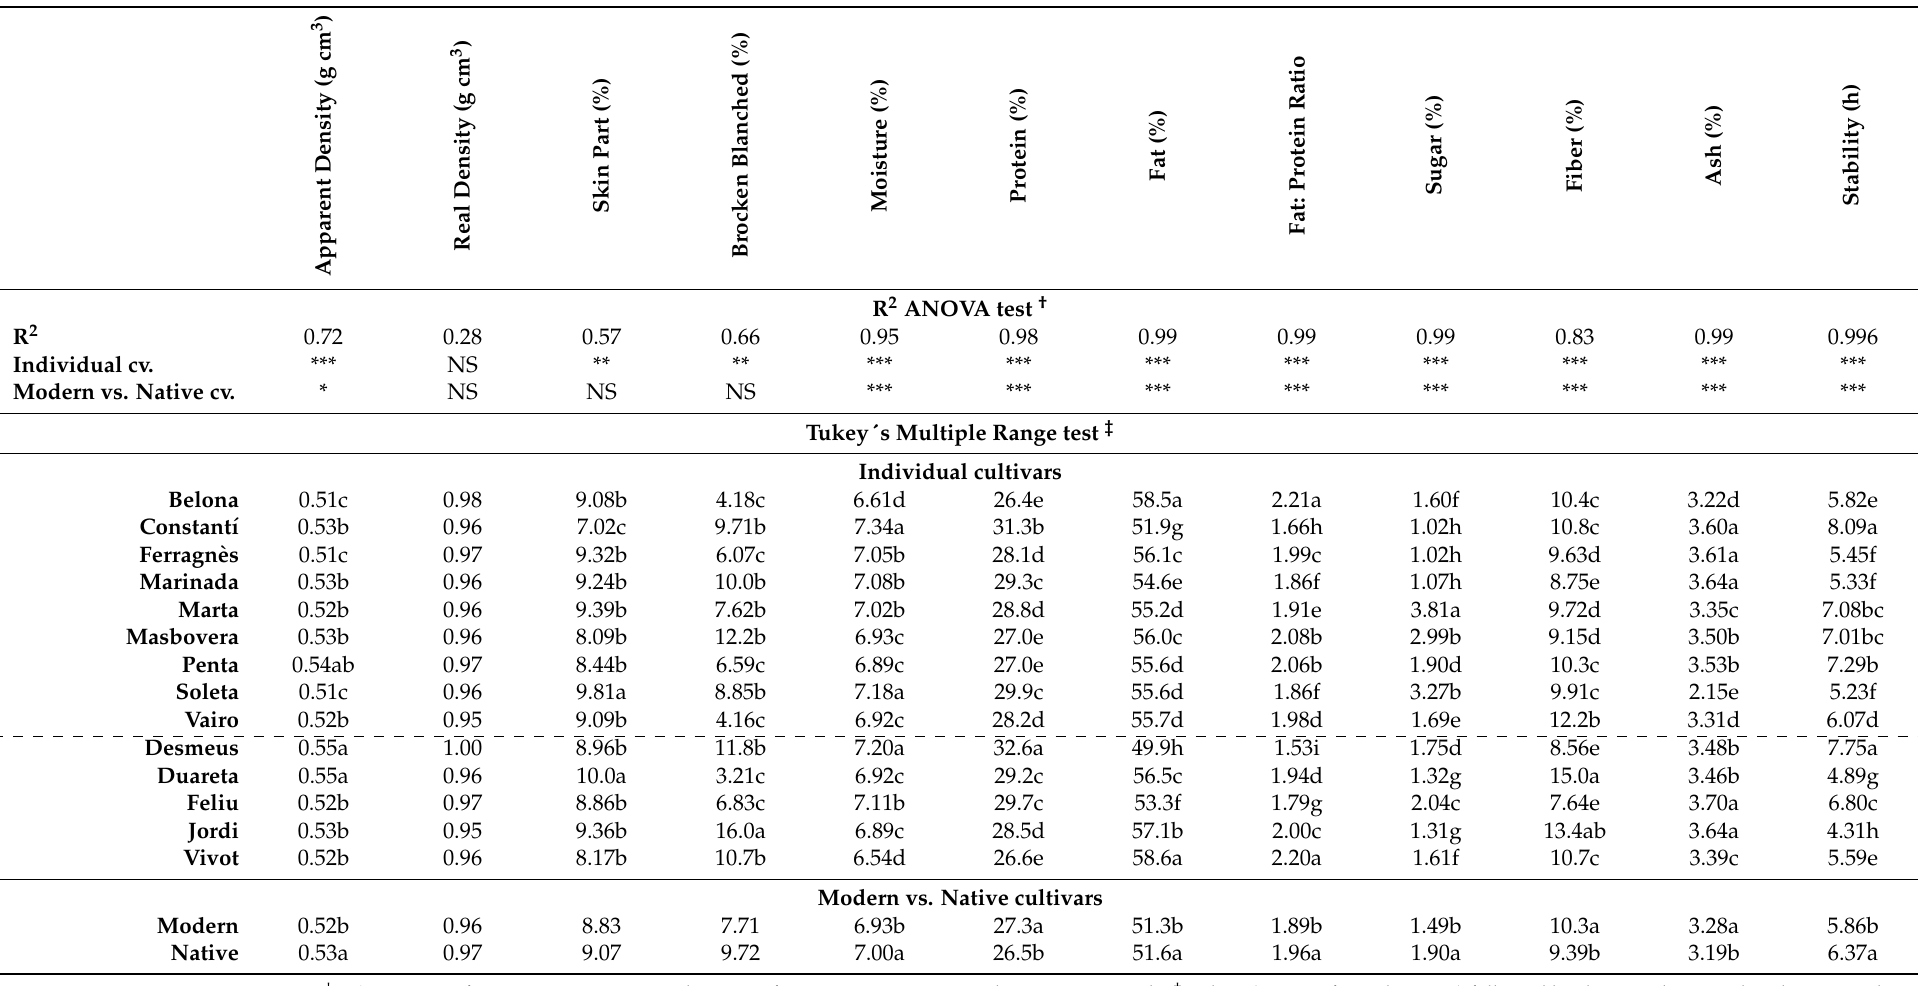
Table 2. Physicochemical parameters measured after blanching process of 14 almond cultivars (9 modern and 5 native